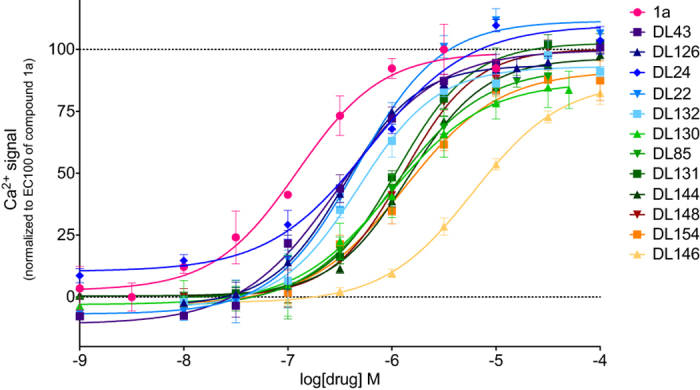
Concentration-response curves of the new GPR139 agonists measured on the NOVO-star using the Fluo-4 Ca2+-assay.The responses are normalized to EC100 of 1a (8 μM) and are ordered by their potency (colour-scale: dark-blue > green > yellow). The graphs are one representative concentration-response curves out of at least three independent experiments performed in triplicates. Data points are means ± SD.